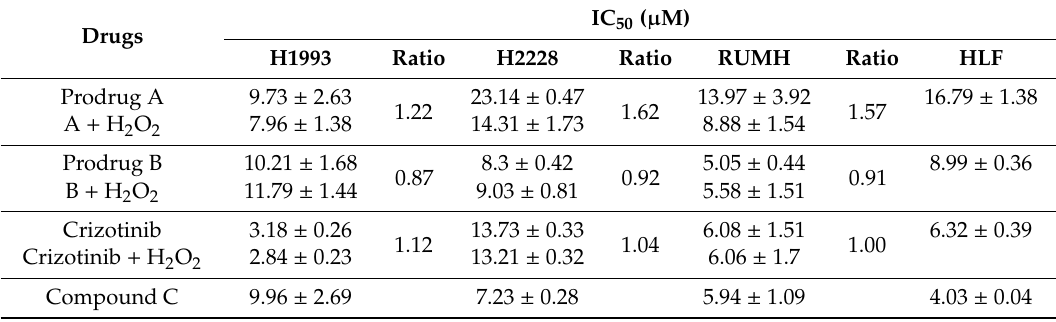
Table 2. Cytotoxicity of prodrug A , prodrug B, compound C , and crizotinib was determined by MTT assay after 72 h treatment. The three cancer cell lines (i.e., H1993, H2228, RUMH) and